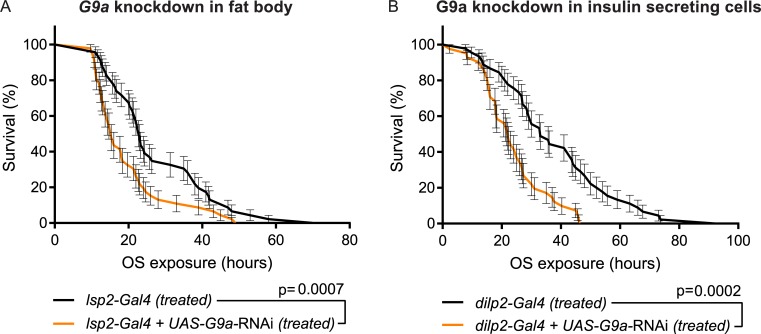
Tissue-specific requirement for G9a in OS response.Kaplan-Meier survival curves comparing G9a-knockdown flies to controls. Knockdown was targeted to (A) fat body and (B) dilp2-expressing cells. (A) Survival curves of flies with fat body–specific G9a knockdown (lsp2-Gal4 + UAS-G9a-RNAi) and controls (lsp2-Gal4) (median survival time: lsp2-Gal4 + UAS-G9a-RNAi, 15 h, n = 46 versus lsp2-Gal4, 23 h, n = 46; p = 0.0007). (B) Survival curves of flies with insulin-secreting cell-specific G9a knockdown (dilp2-Gal4 + UAS-G9a-RNAi) and controls (dilp2-Gal4) (median survival time: dilp2-Gal4 + UAS-G9a-RNAi, 22 h, n = 41 versus dilp2-Gal4, 33 h, n = 45; p = 0.0002). Fat body–or insulin-secreting cell–specific drivers were combined with a UAS-G9a RNAi construct (lsp2-Gal4 + UAS-G9a-RNAi [A], dilp2-Gal4 + UAS-G9a RNAi [B]) to repress G9a expression in a tissue/cell-specific manner or crossed to the isogenic background of the RNAi lines to generate the isogenic controls. Survival curves showing percent survival and SE over time were plotted using Graphpad, and p-values were obtained using the Gehan-Breslow-Wilcoxon test. All experiments were independently replicated at least three times. The numerical data depicted in this figure can be found in S5 Data. OS, oxidative stress; RNAi, RNA interference; SE, standard error.